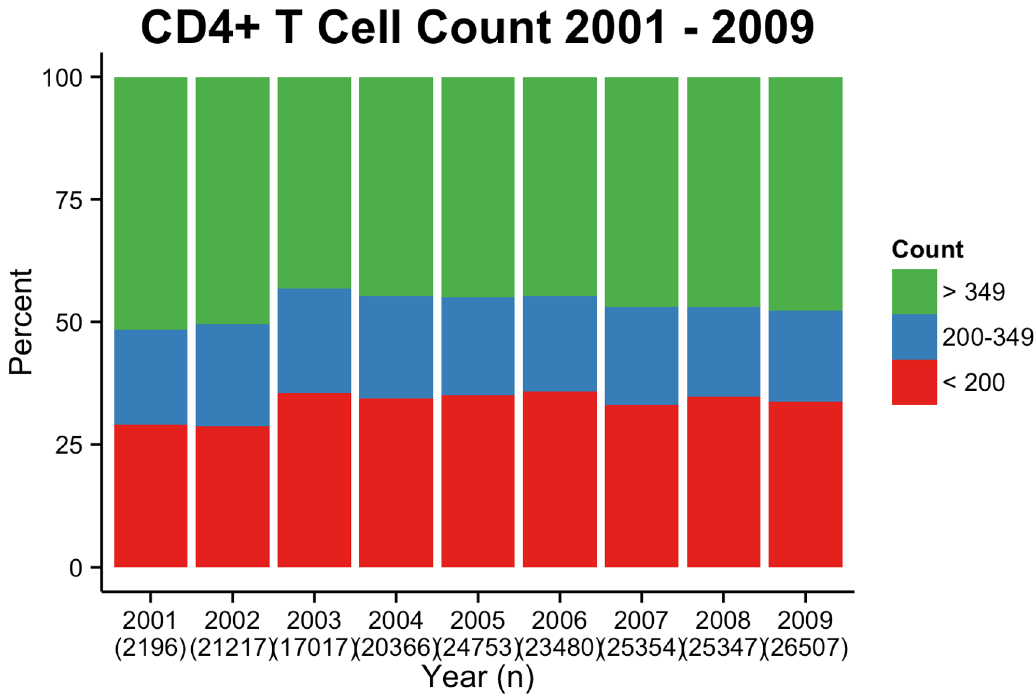
Fig 1. CD4 cell counts at initial screening. CD4+ T cell counts among antiretroviral na ï ve individuals at first presentation from 2001 to 2009.